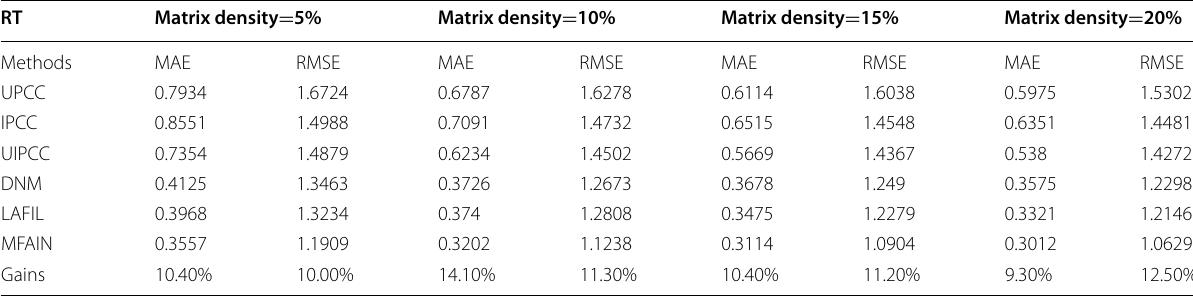
Table 4 Performace comparison for response time